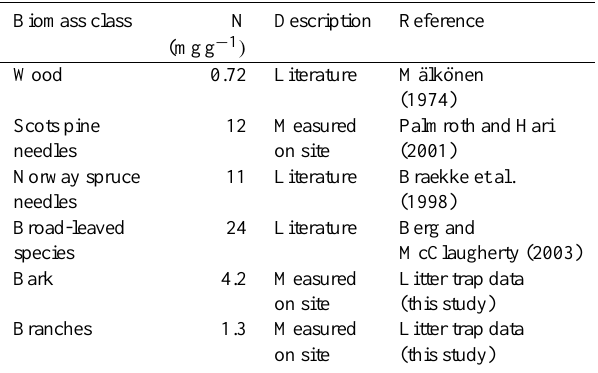
Table 1. Nitrogen concentrations of aboveground biomass classes used for biomass nitrogen pool calculations. The wood concentra- tion was measured in Juupajoki, near the measurement site.